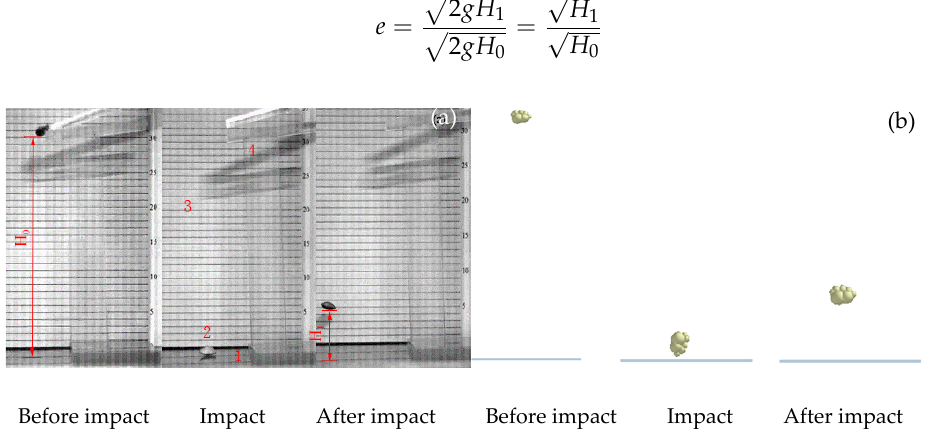
Figure 3. Restitution coefficient calibration test: ( a ) direct measurement: 1 Wall; 2 Clam; 3 Graph paper; 4 Testbed ( b ) DEM simulation test.